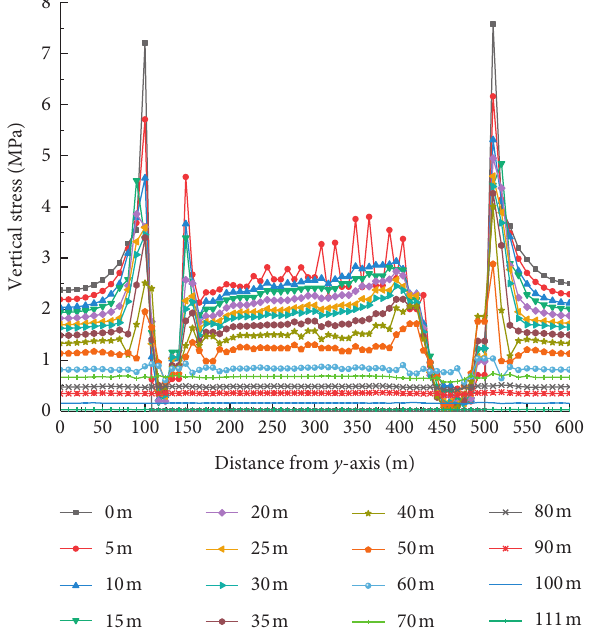
Figure 9: Distribution of vertical stress on strike observation surface.